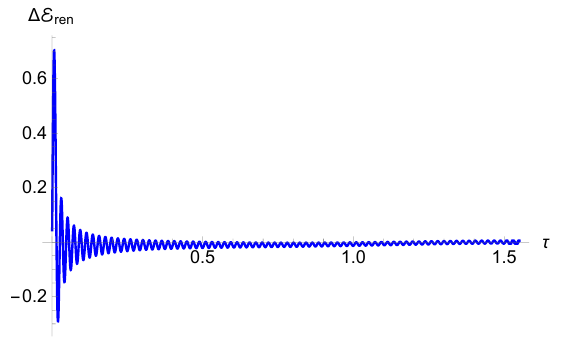
Figure 4 . The change in the total renormalized energy as a function of (cid:28) for (cid:21) 0 = 16 (cid:25) and (cid:21) 0 (cid:27) 0 = 0 : 2. The scale of the oscillations appear much larger than or comparable to the mean value.